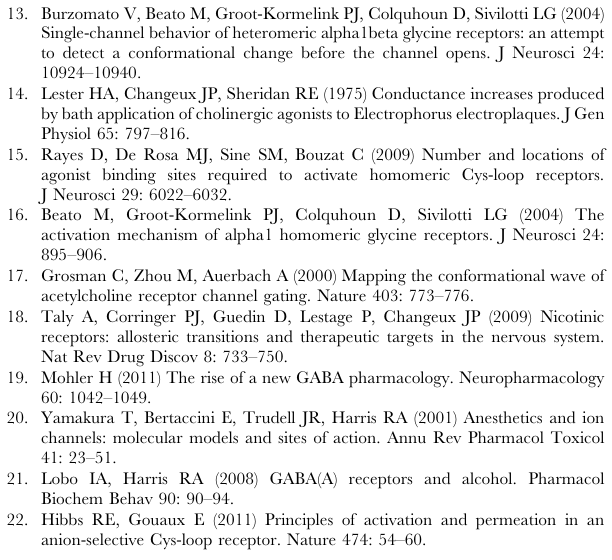
Figure S3 Divalent ion inhibition in mutants of the regulatory site S out . Dose–response relationships of the ELIC mutants D113N (A), D158N (B), and E150Q (C) activated by cysteamine at different concentrations of Ca 2 + are shown. (D) Schild plots quantifying the inhibition of ELIC mutants by Ca 2 + . (E) Dose– response relationships of the ELIC double mutant D113A/D158A activated by cysteamine at different concentrations of Ba 2 + are shown. (F) Schild plot quantifying the inhibition of the ELIC double mutant D113A/D158A by Ba 2 + . EC 50 values were obtained from data shown in panels (A–C) and (E). Potencies of the antagonists (pA values) in (D) and (F) were obtained by linear regression; the intersection with the x -axis is indicated ( N ). WT is shown for comparison. The data presented in panels (A–C) and (E) are averages from at least 5 oocytes; errors are SD. The solid lines show fits to a Hill equation. Currents were recorded at 2 40 mV. A dose–response curve of WT in the absence of Ca 2 + (dashed line) is shown for comparison. Figure S4 Divalent ion inhibition in mutants of histidine residues in the extracellular domain. Dose–response relationships of the ELIC mutants H168A (A) and H176A (B) activated by cysteamine at different concentrations of Ca 2 + are shown. (C) Schild plots quantifying the inhibition of ELIC mutants by Ca 2 + . EC 50 values were obtained from data shown in panels (A–B). Potencies of the antagonists (pA values) were obtained by linear regression; the intersection with the x -axis is indicated ( N ). WT is shown for comparison. The data presented in panels (A–B) are averages from at least 5 oocytes; errors are SD. The solid lines show fits to a Hill equation. Currents were recorded at 2 40 mV. A dose–response curve of WT in the absence of Ca 2 + (dashed line) is shown for comparison. Figure S5 Inhibition by tetramethylammonium (TMA). Dose– response relationships of WT (A) and the mutant R91A (B) activated by cysteamine at different concentrations of TMA are shown. A dose–response curve of WT in the absence of TMA (dashed line) is shown for comparison. (C) Schild plots quantifying the inhibition by TMA. EC 50 values were obtained from data shown in panels (A–B). Potencies of the antagonists (pA values) were obtained by linear regression; the intersection with the x -axis